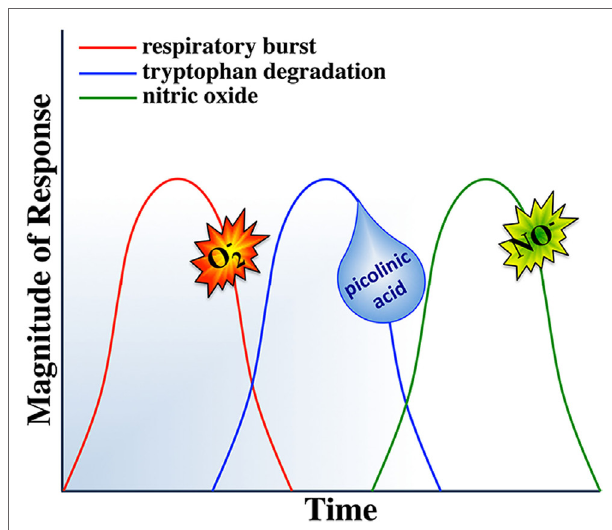
FigURe 5 | Sequential activation of macrophage